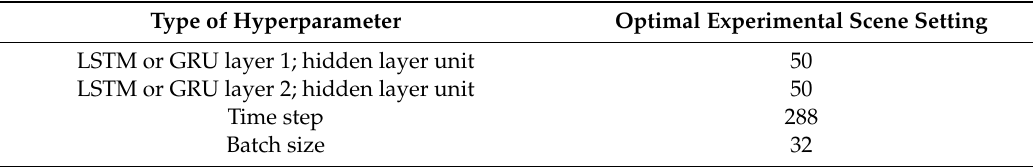
Table 5. List of optimal